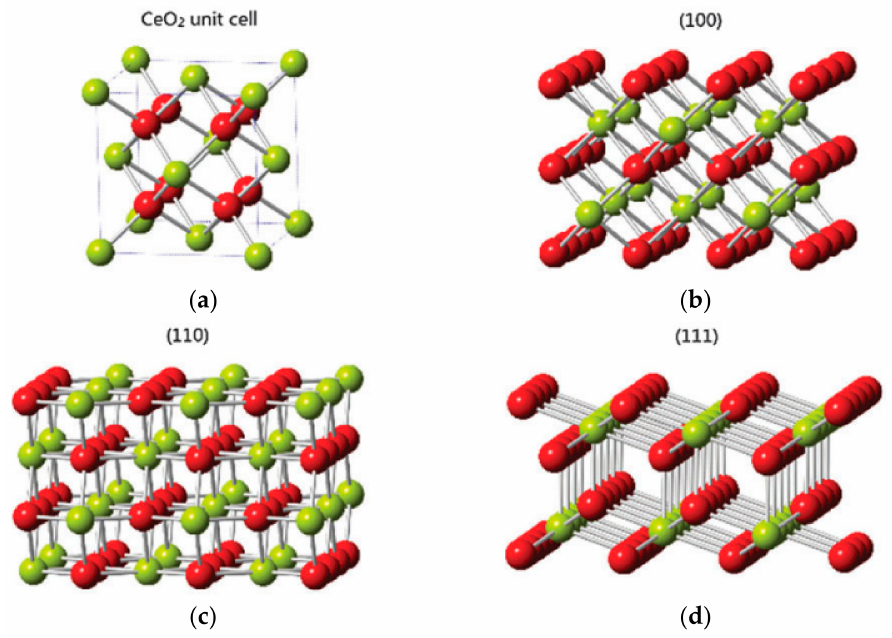
Figure 1. ( a ) CeO 2 FCC Unit cell, ( b – d ) the (100) [or (200)], (110), and (111) planes of the CeO 2 structure, reprinted with permission from [41]. Copyright Royal Society of Chemistry,